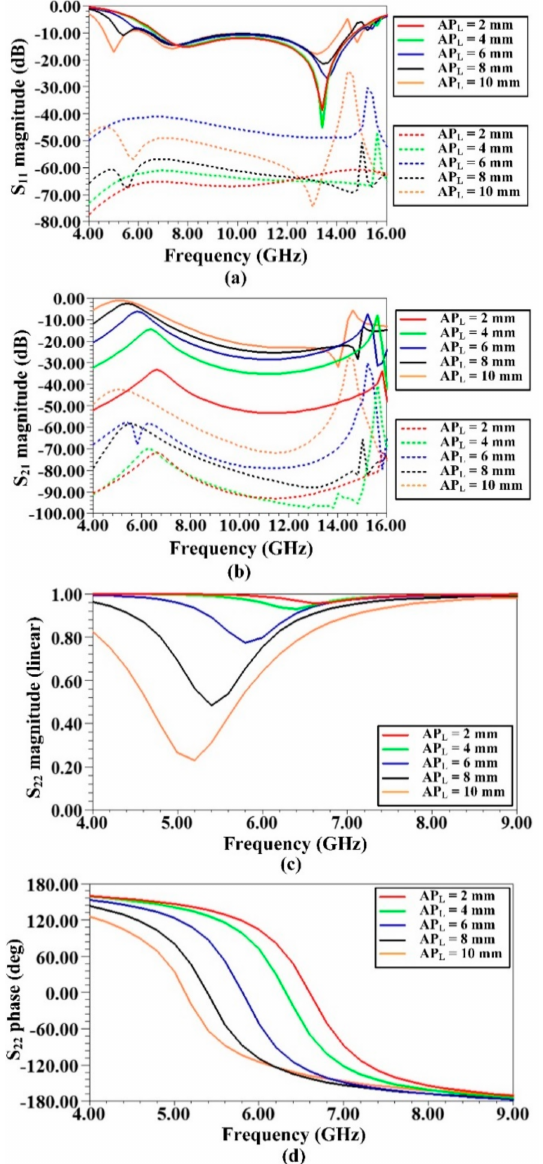
Figure 2. Unit cell scattering parameters for ± z-axis incident wave (TE polarization). ( a ) S 11 mag- nitude response. ( b ) S 21 magnitude response. ( c ) S 22 magnitude (linear) response. ( d ) S 22 phase response. (Note: The dashed traces shown in ( a , b ) represent cross-coupled/polarized reflection and transmission